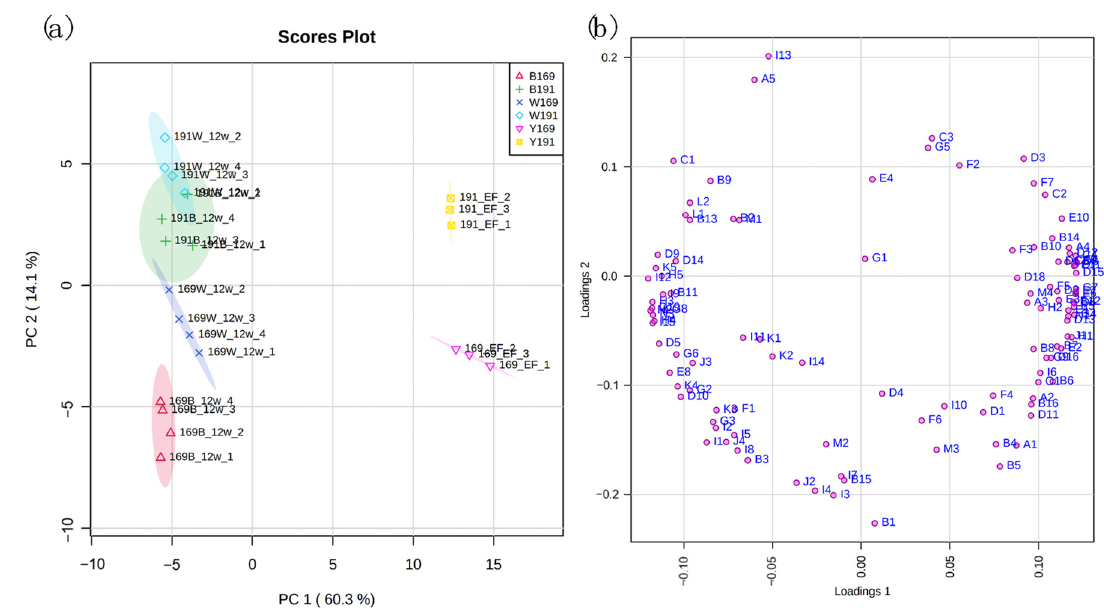
Figure 2. ( a ) Score plot and ( b ) loading plot of principal component analysis using the detected volatiles as the variables. Y191 and Y169 represent wine made of clone 191 and 169 before aging, respectively. W191 and W169 represent wine made of clone 191 and 169 aged in Wolin oak barrel for 12 months, respectively. B191 and B169 represent wine made of clone 191 and 169 aged in Bordeaux oak barrel for 12 months, respectively. The codes of volatile compounds in the loading plot refer to Table S1.